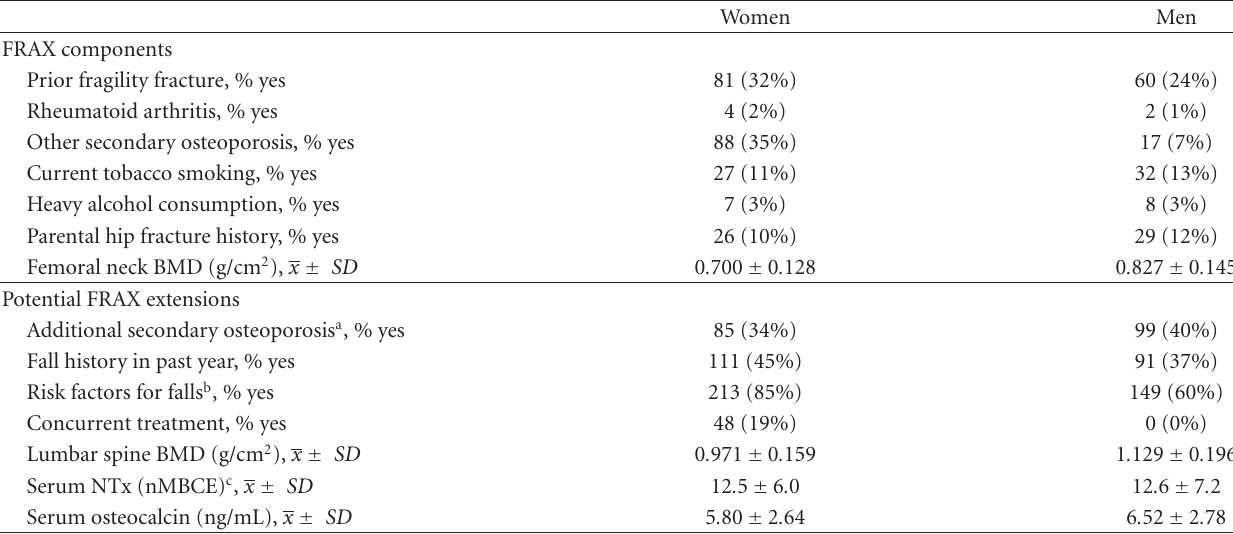
Table 1: Fracture risk factors at baseline among 250 women and 249 men ≥ 40 years of age randomly sampled from the Rochester, MN